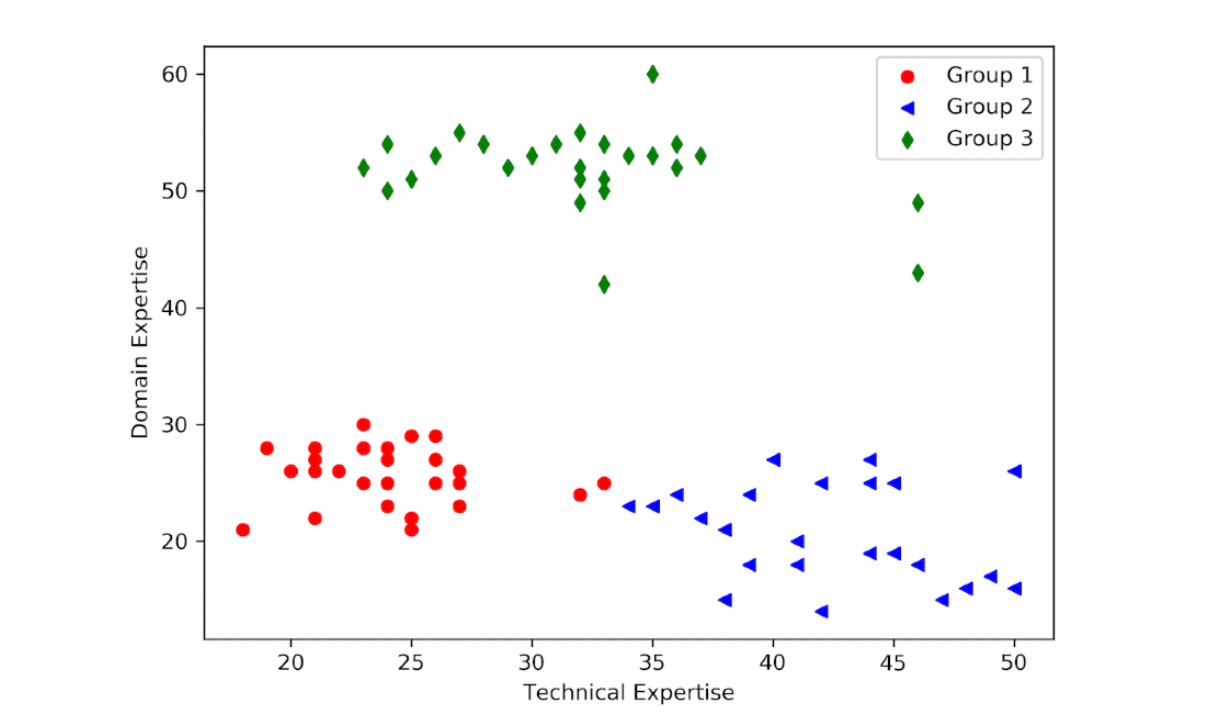
Figure 7. Clustering results on participant domain expertise and technical